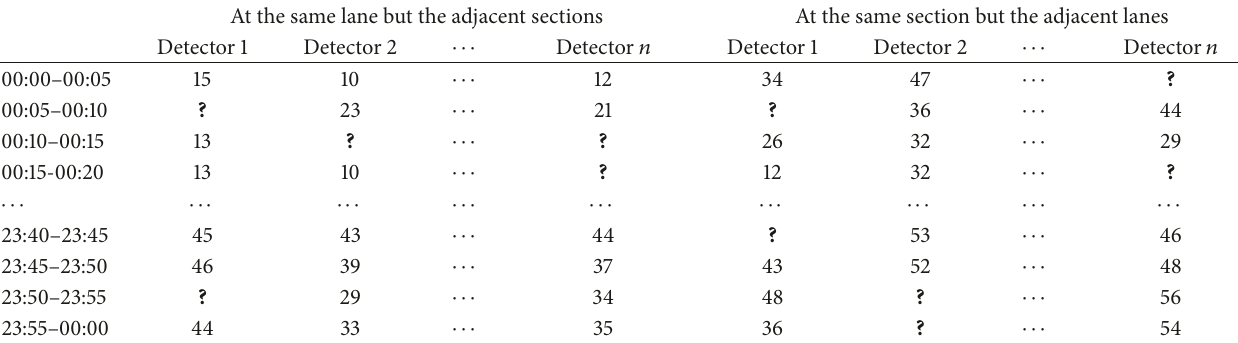
Table 3: A matrix-based missing data representation for “section pattern” and “lane pattern.” At the same lane but the adjacent sections At the same section but the adjacent